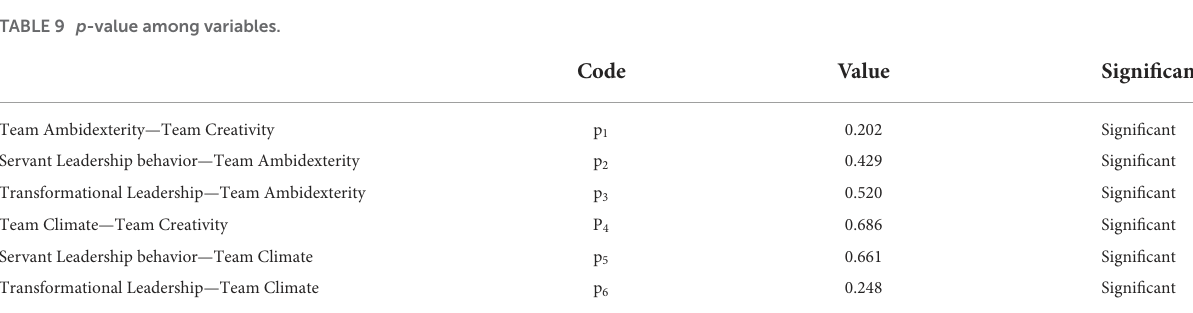
TABLE 9 p -value among